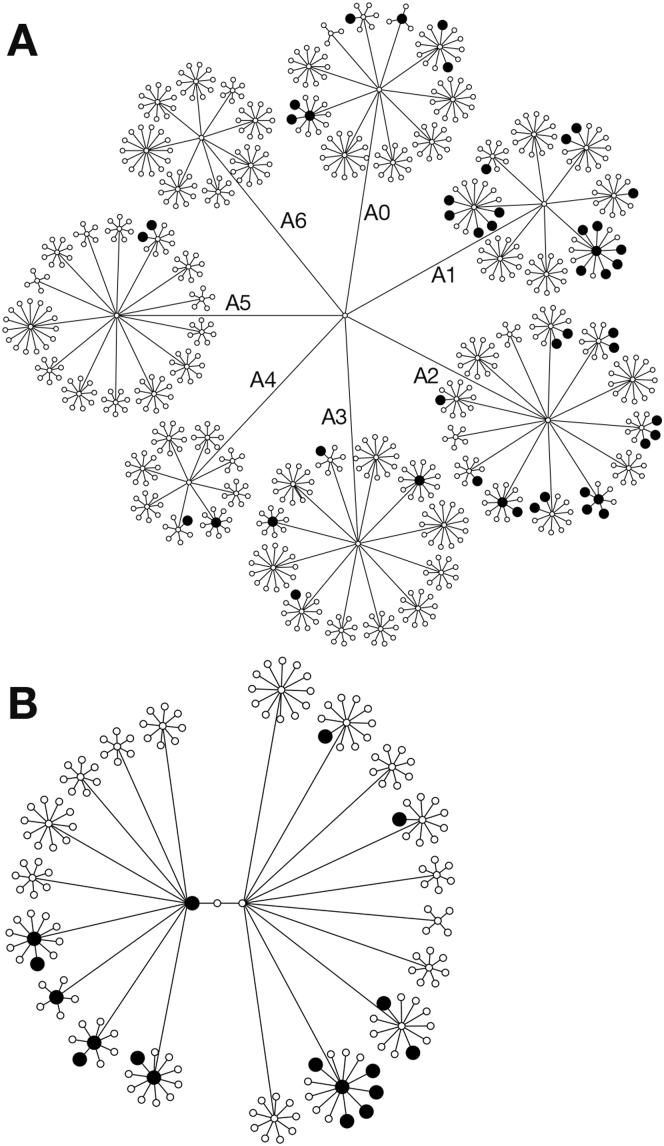
Pedigrees showing all affected (filled symbols, larger for clarity) and unaffected individuals in the first 4 generations of (A) Family A and (B) Family B. All individuals are shown as circles regardless of sex. (A) Subfamilies have been labeled A0–A6. The pedigrees have been modified slightly for reasons of anonymity. Deceased individuals have been included but not identified. For simplicity, founders entering the pedigrees have not been included.